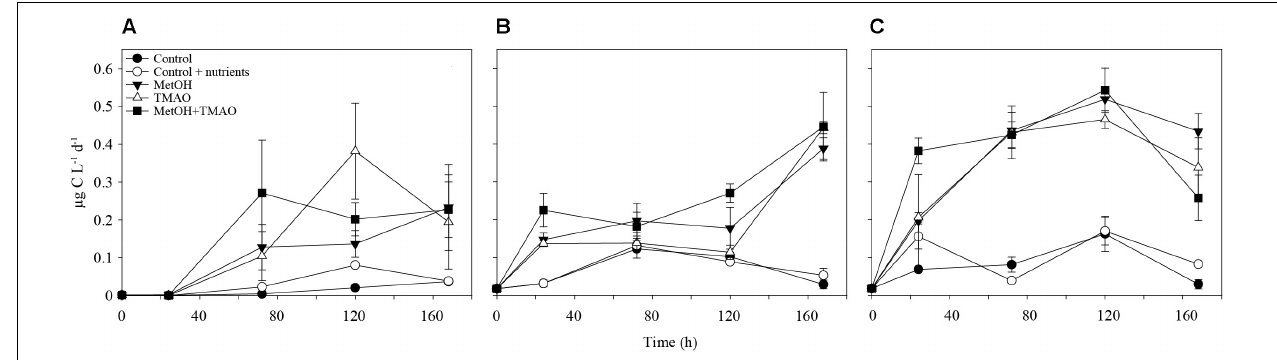
FIGURE 2 | Methanol assimilation over the course of the experiment in winter (A) and summer (B) and methanol respiration in summer (C) . Mean ± standard deviation, n = 3.